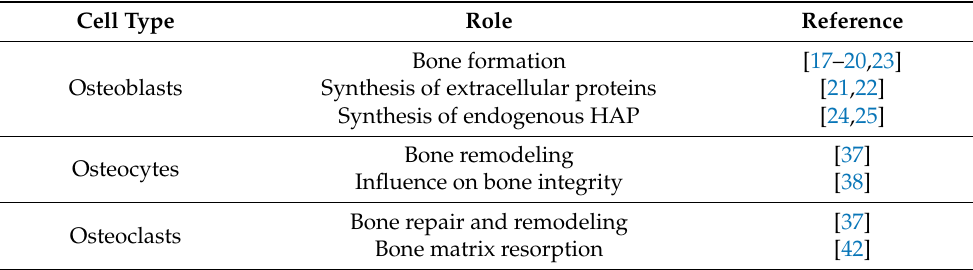
Table 1. Bone cells. Types and